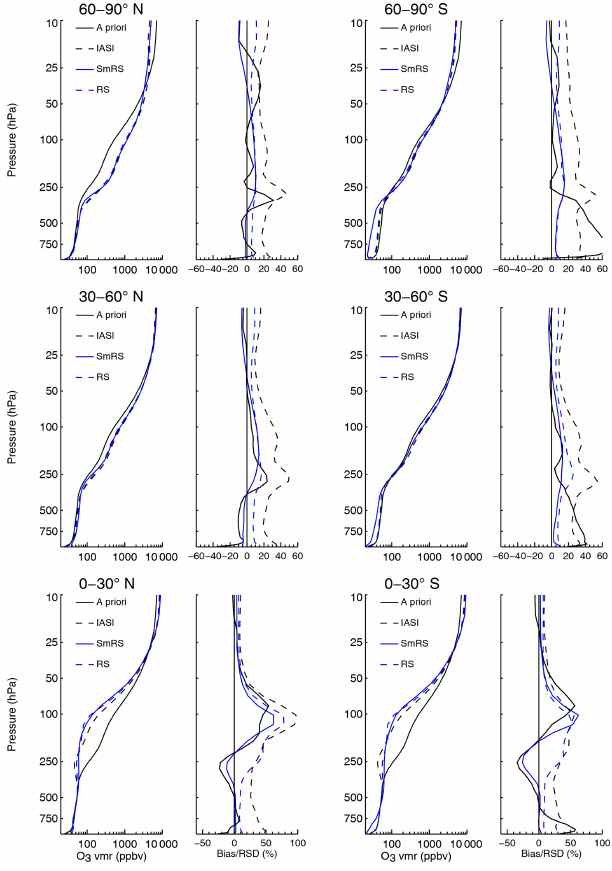
Figure 7. Profile comparisons between sonde and SOFRID-O3 v1.6 a priori profiles (left panels) (solid black lines), IASI (dashed black lines), smoothed (SmRS, solid blue lines) and raw (RS, dashed blue lines) sonde vertical profiles, biases (right panels) (solid lines) and RMSD (dashed lines) between IASI and raw (black lines) and smoothed (blue lines) sondes for the NH (left panels) and SH (right panels).